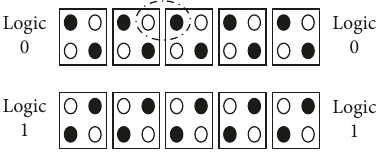
Figure 3: QCA binary